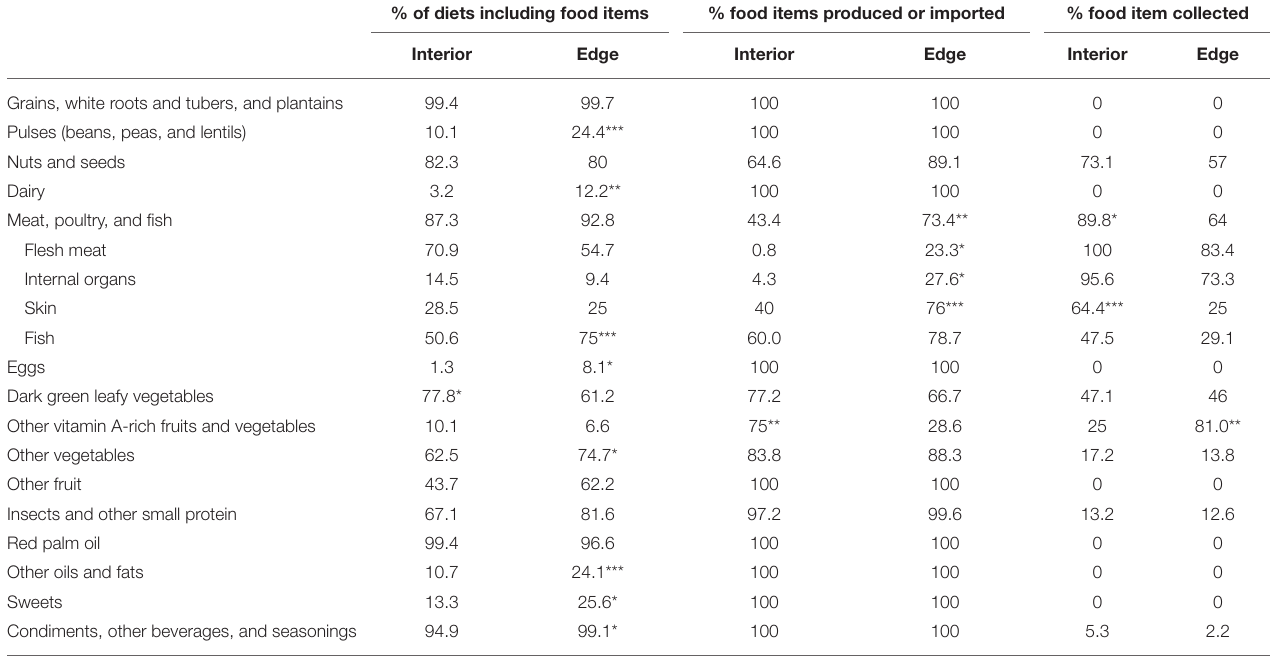
TABLE 2 | Consumption of food items and the sources of those foods in diets of deep and forest-edge communities based on 24-h recall data. % of diets including food items % food items produced or imported % food item collected Interior Edge Interior Edge Interior Edge Grains, white roots and tubers, and plantains 99.4 99.7